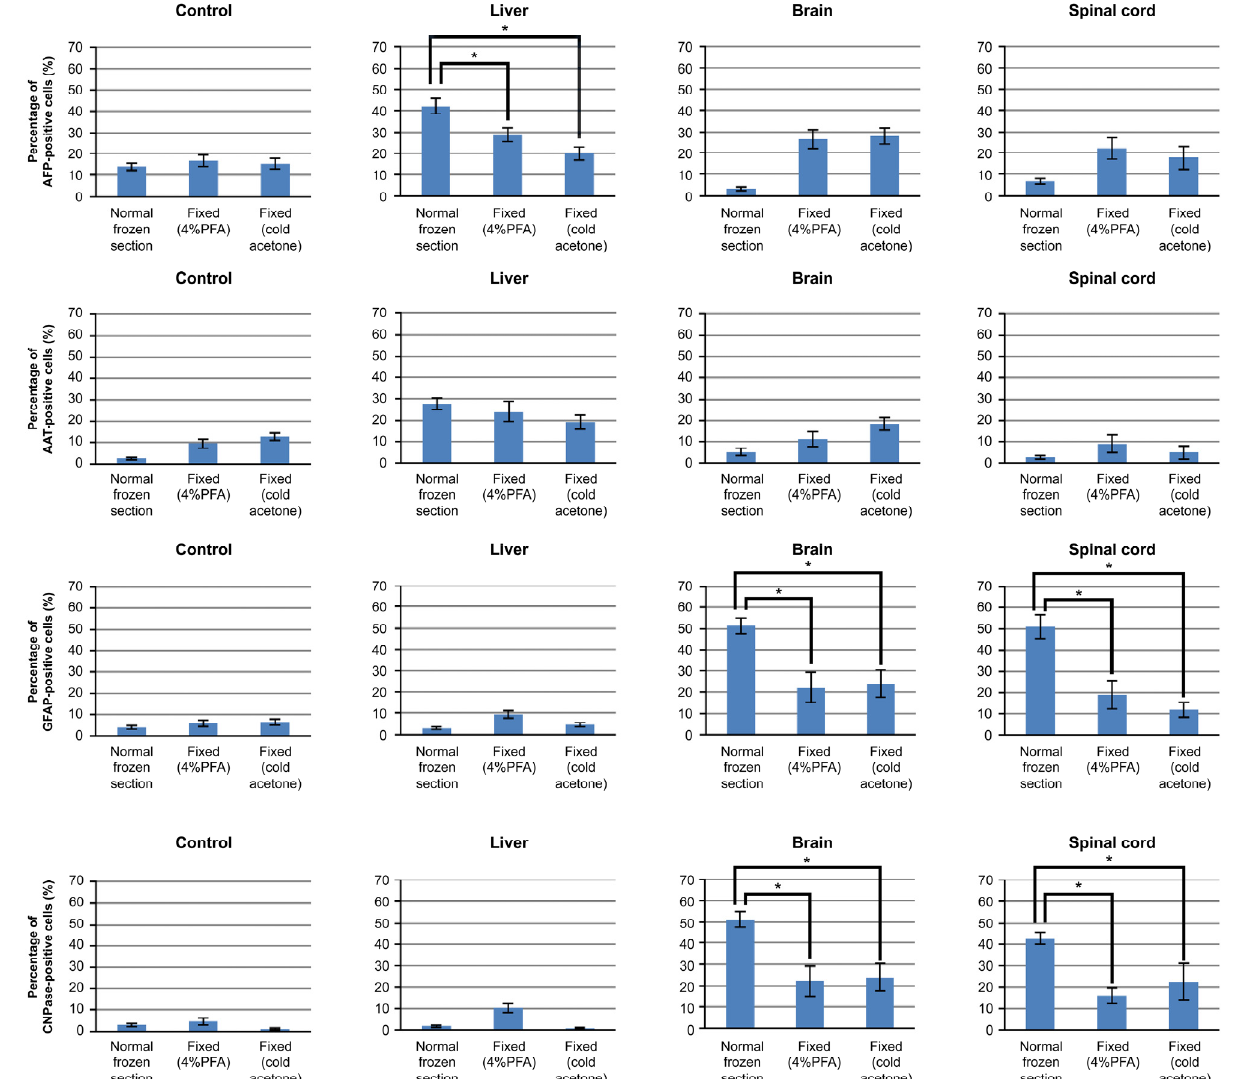
Figure 4. Immunocytochemical analysis for the expression of hepatocytic (AFP and AAT) and neurogenic (GFAP and CNPase) markers in the HPS77 cells cultured on the unfixed or fixed frozen sections with 4% PFA or cold acetone. Statistically more HPS77 cells expressed hepatocytic markers (AFP) when cultured on unfixed frozen sections of the liver compared with when cultured on the fixed frozen sections. On the contrary, more HPS77 cells expressed neural markers (GFAP and CNPase) when cultured on unfixed frozen sections of the brain/spinal cord than when cultured on the fixed frozen sections. Note: * p < 0.05.